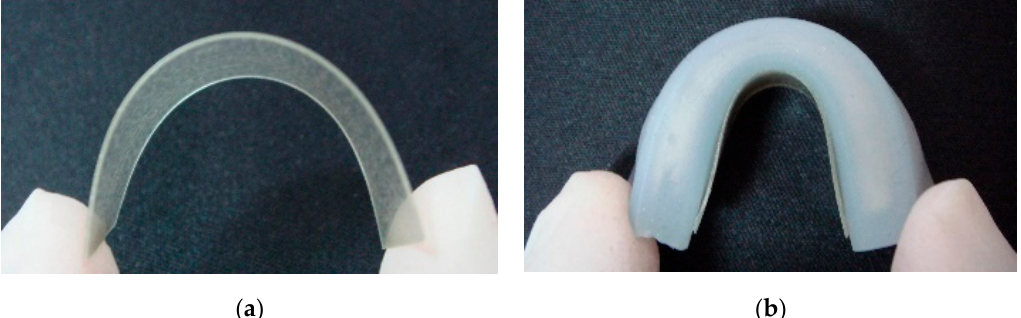
Figure 7. Bonded flexible FEP electret with conductive film ( a ) and fabricated flexible and stretchable energy harvester ( b ).